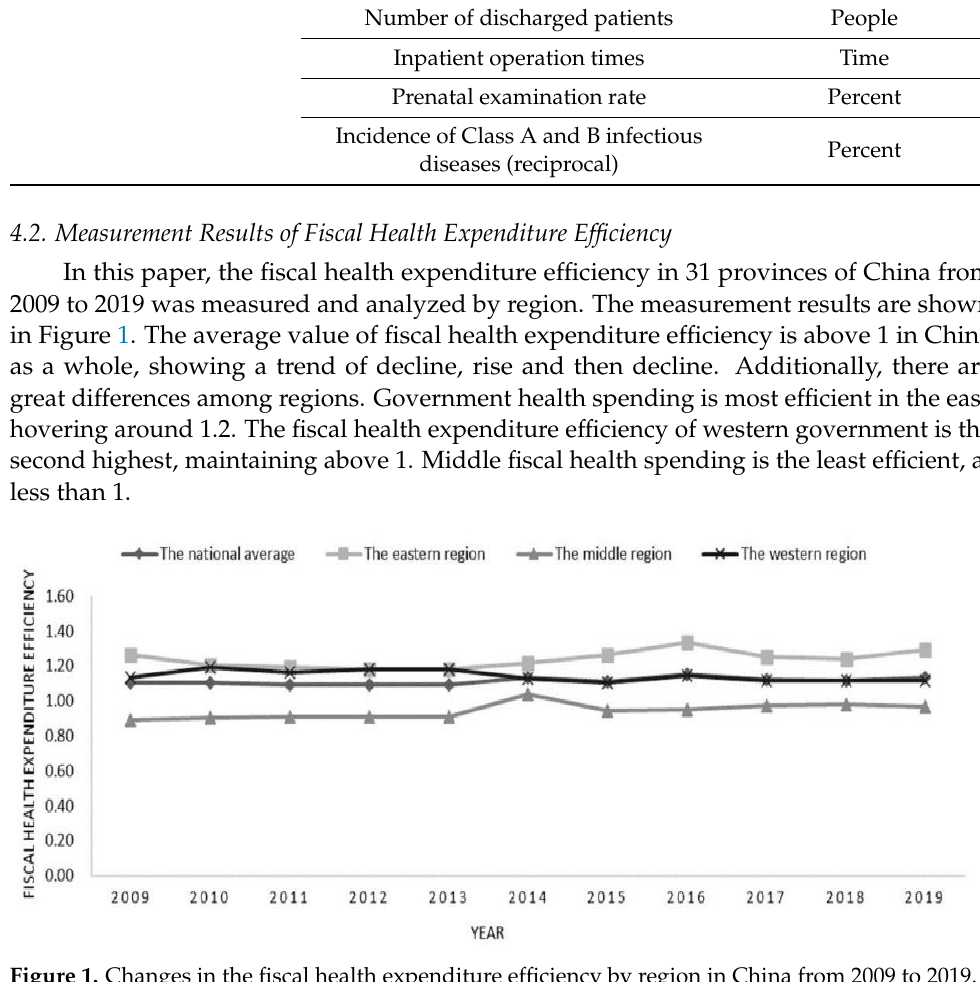
Table 1. Fiscal health expenditure efficiency index system.